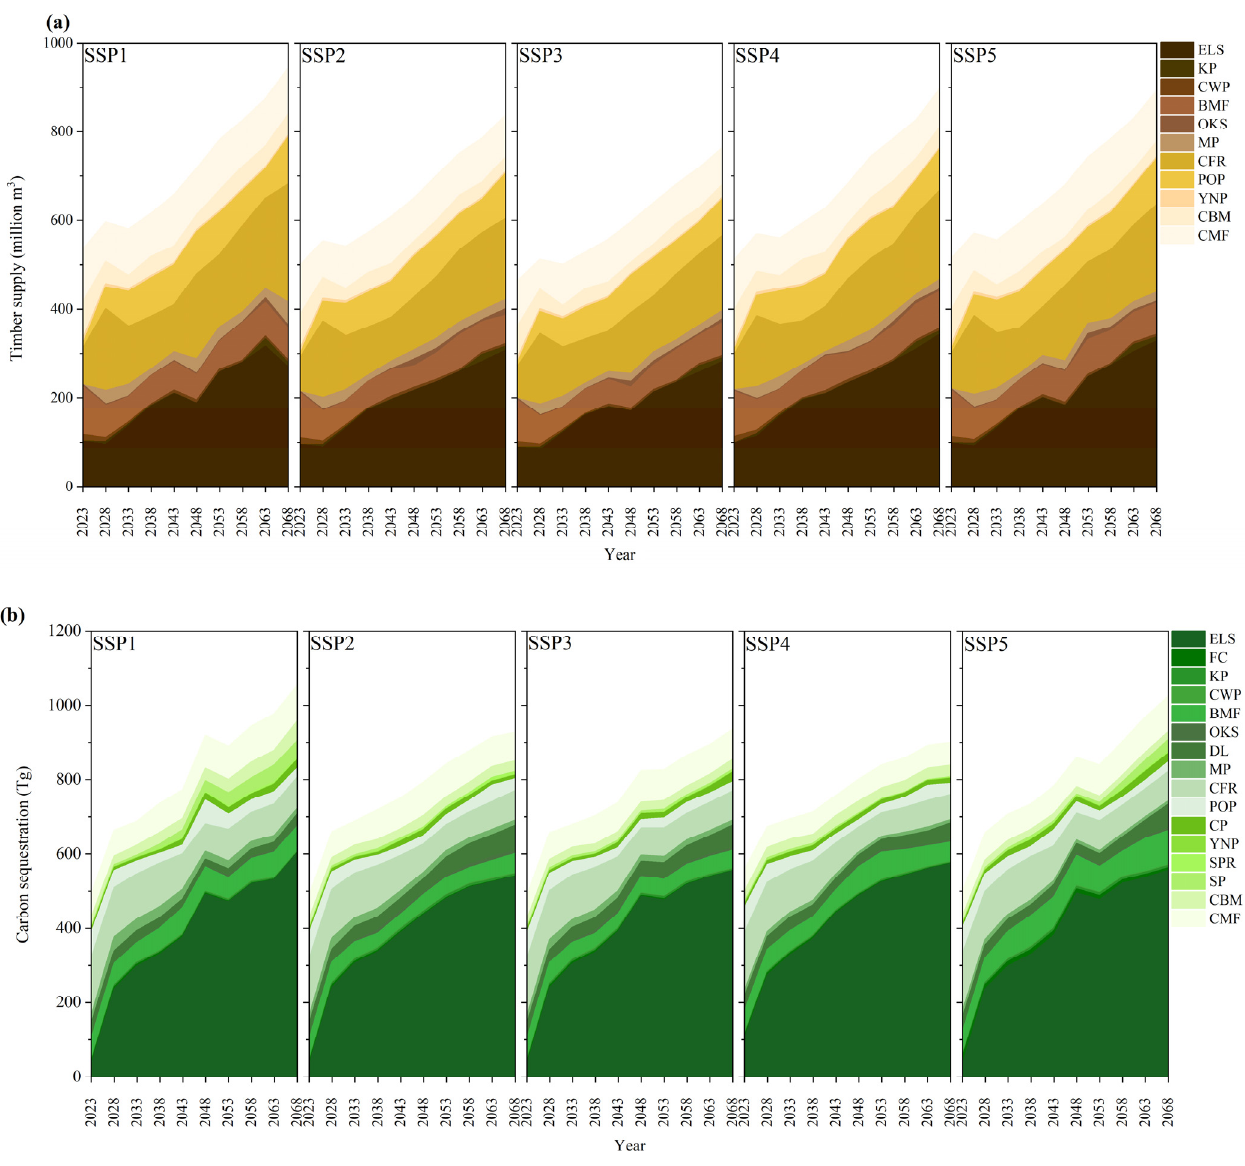
Figure 3. Tree species of projected timber yields ( a ) and carbon sequestration ( b ) by SSPs in ten five-year periods. An explanation of each tree name abbreviation is shown in Table A4.